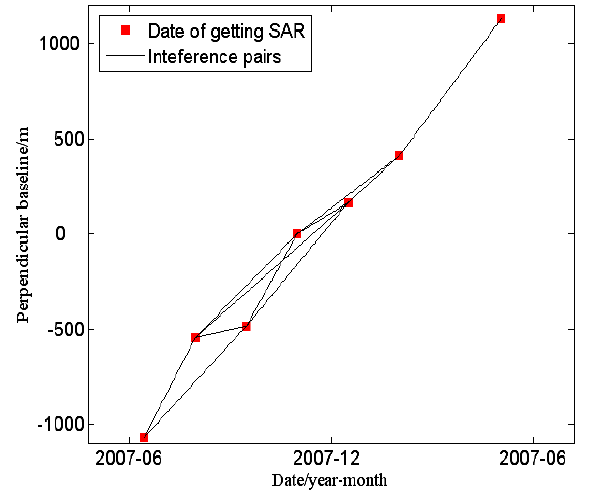
Figure 1. The schedule of SAR